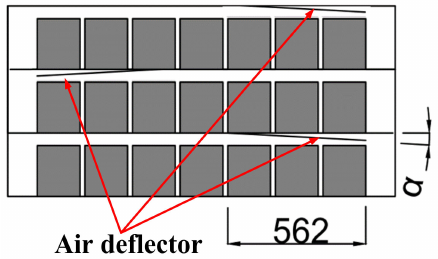
Figure 18. Schematic diagram of battery pack